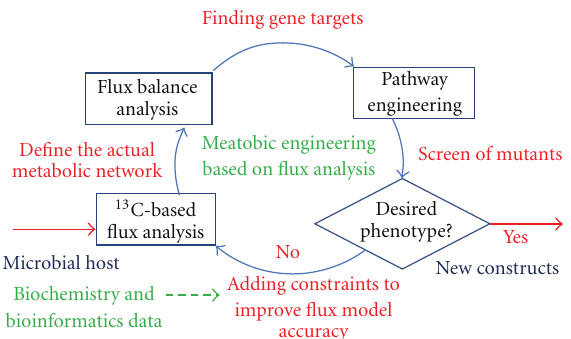
Figure 1: An iterative approach of fluxomic analysis and rational metabolic